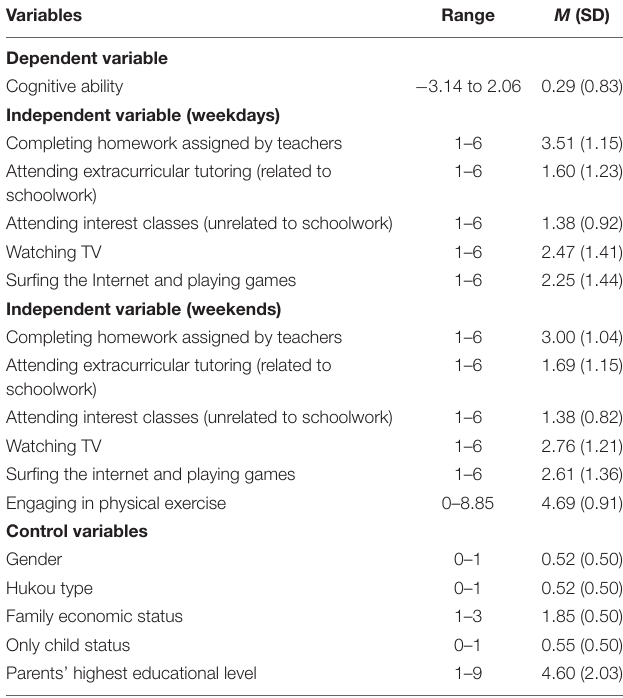
TABLE 1 | Means and standard deviations of all variables.